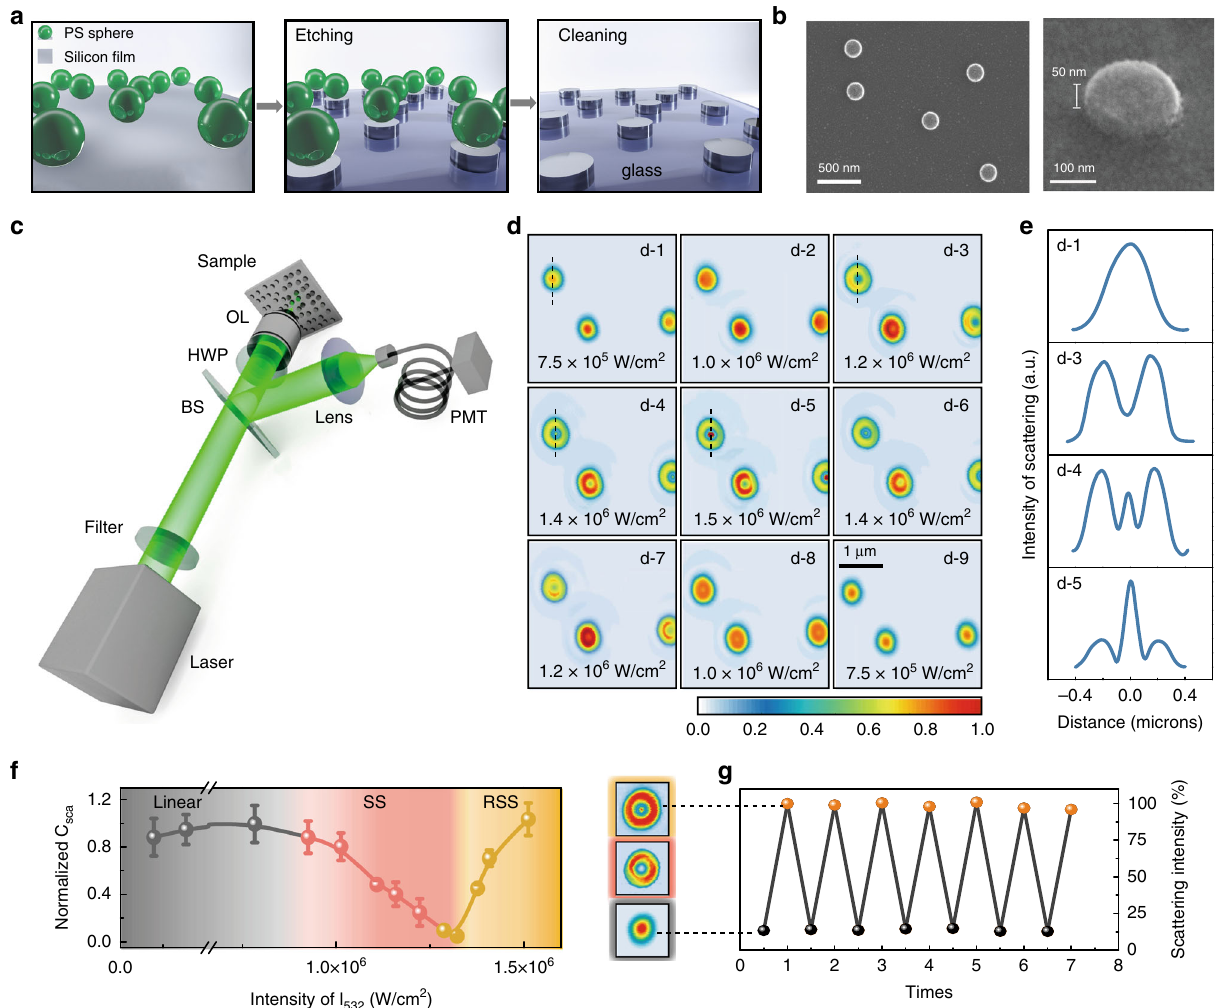
Fig. 2 Nonlinear scattering measurements. a Schematic fabrication processes of isolated Si nanodisks. b SEM images as well as 30° tilted view, showing the resulting Si nanodisks with diameter of 200 nm and height of 50 nm. c Optical setup of the re fl ected laser scanning confocal microscope. HWP half- wave plate, BS beam splitter, OL objective lens, PMT photomultiplier tube. d Measured PSFs under different laser intensities at the wavelength of 532 nm. e The intensity lateral pro fi le of the selected nanodisks (black dashed lines in d ). f The evolution of normalized scattering cross section with excitation intensities. The error bars show the standard deviations of normalized scattering cross sections according to statistics of 12 nanodisks. g Reversibility of nonlinear scattering is con fi rmed by the full recovery of scattering intensities as well as corresponding PSFs from the same nanodisk under repetitive